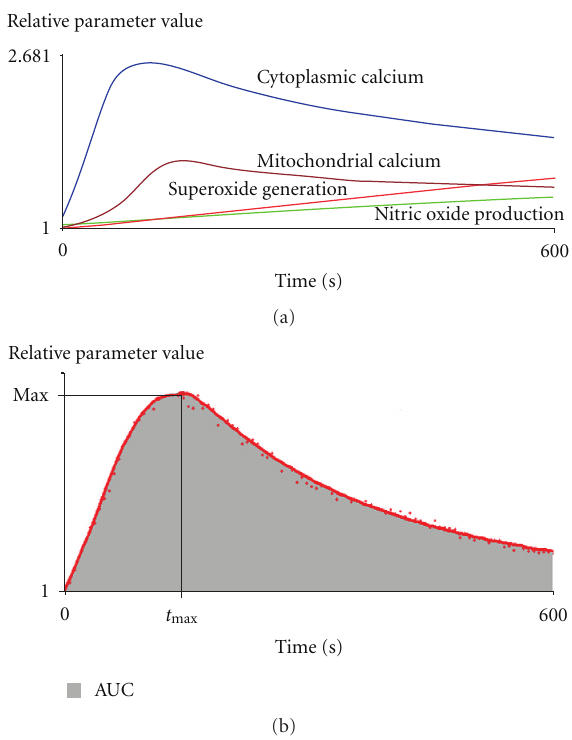
Figure 1: Schematic demonstration of characteristics changes of intracellular processes following PHA activation of lymphocytes. AUC: area under the curve, Max: maximum value, t max : time to reach